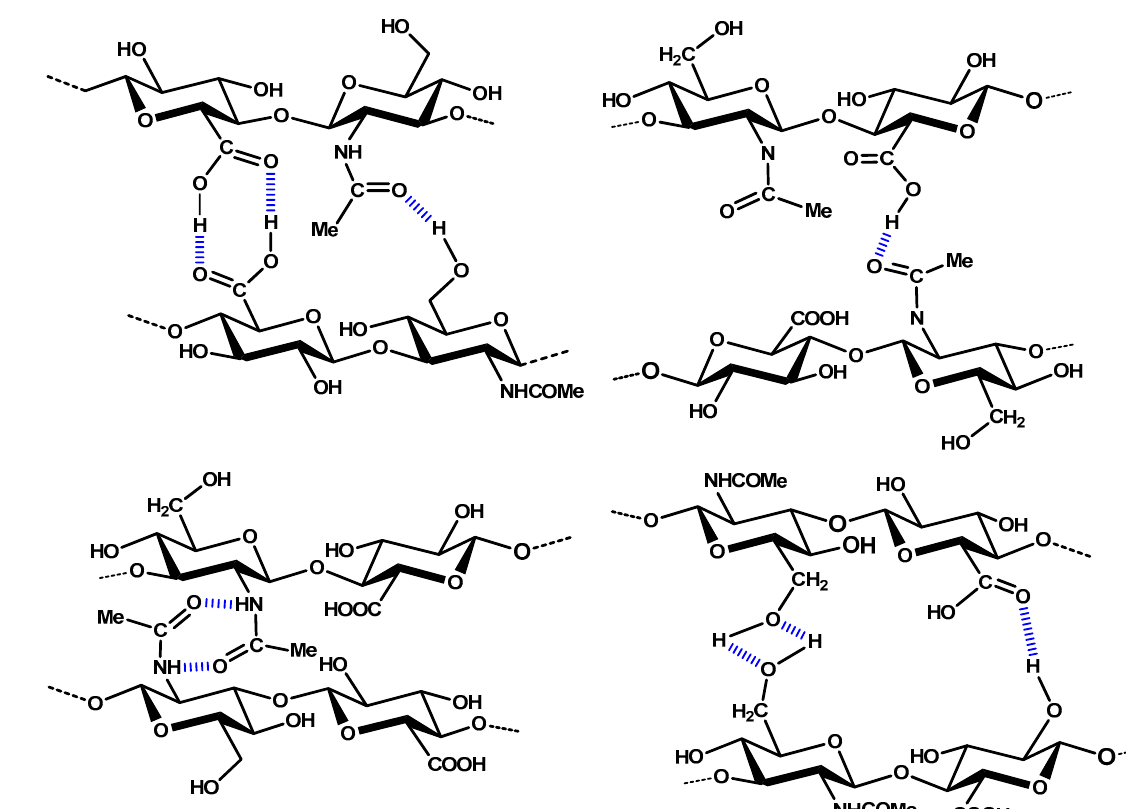
Figure 4. Possible forms of hydrogen bonds between -OH, -COOH, and NHCOCH 3 groups exemplified by hyaluronan gels (scheme modified according to [64]).